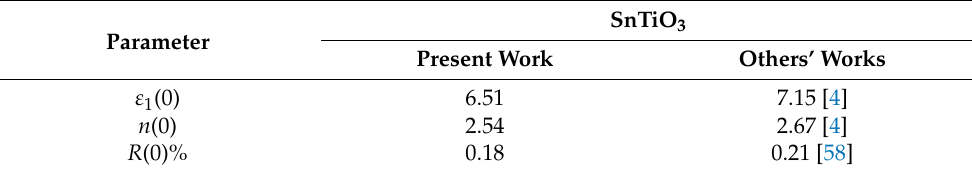
Figure 6. Spectra of the ( a ) real ε 1 ( ω ) and imaginary ε 2 ( ω ) dielectric functions, ( b ) refractive indices n ( ω ) and extinction coefficient K ( ω ), ( c ) Absorption coefficient α ( ω ), and ( d ) conductivity against photon energy (eV) of cubic SnTiO 3 obtained using the nmBJ-GGA method. Table 4. Calculated and Reported Theoretical optical properties for SnTiO 3 .